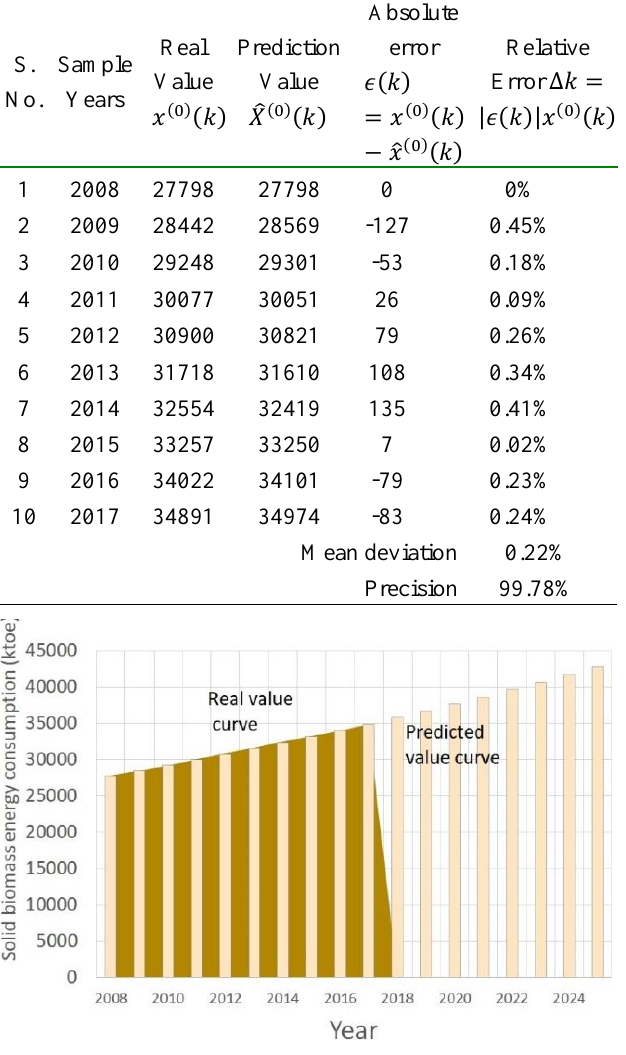
Fig. 3. GM (1,1) model forecast for Ethiopian solid biomass energy consumption